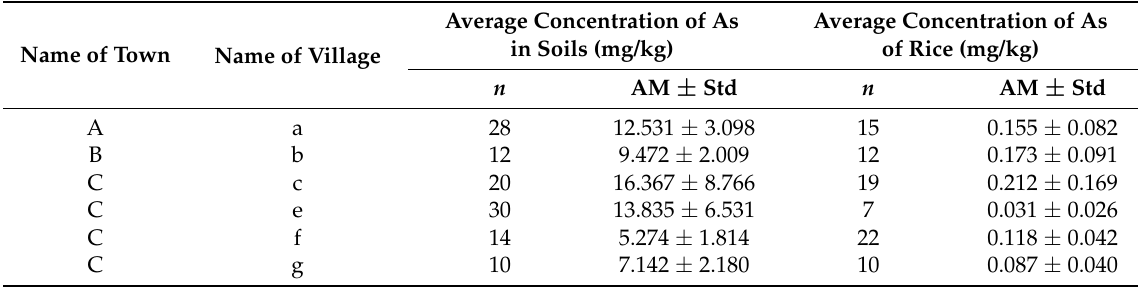
Table 7. Arsenic concentration in the soil and rice crop specimens collected from the studied area.